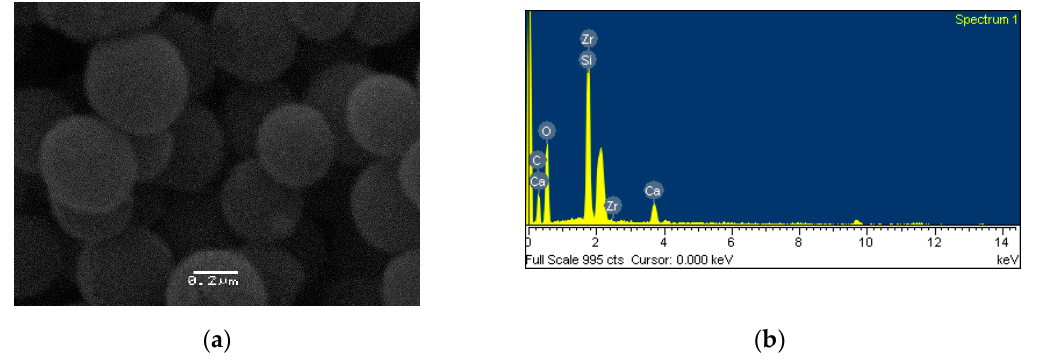
Figure 6. Scanning electron microscopy (SEM) micrograph and EDS spectrum data for SiO 2 @ZrO 2 0.06M–CaO at 700 °C: ( a ) SEM image; ( b ) EDS spectrum.